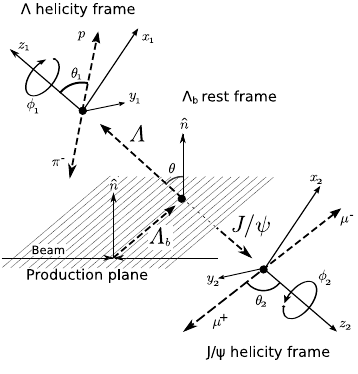
Figure 6. Definition of the decay angles. The angle θ is the polar angle of the Λ 0 momentum measured from the normal direction ˆ n in the Λ 0 b rest frame. The angles θ 1 and φ 1 are the polar and azimuthal angles of the proton in the Λ 0 rest frame with respect to the Λ 0 direction in the Λ 0 b rest frame. Similarly, θ 2 and φ 2 are polar and azimuthal angles of μ + in the J /ψ rest frame with respect to the J /ψ direction in the Λ 0 b rest frame. The azimuthal angles, φ 1 and φ 2 , are measured in the Λ 0 and J /ψ rest frame right-handed coordinate systems, ( x 1 ,y 1 , z 1 ) and ( x 2 ,y 2 , z 2 ), respectively. The z 1 , 2 -axes are aligned with the direction of Λ 0 and J /ψ , respectively, and the x 1 , 2 -axes lie in the plane containing ˆ n and the Λ 0 or J /ψ momenta. With this definition, the angle φ 1 + φ 2 is actually the angle between the Λ 0 and J /ψ decay planes